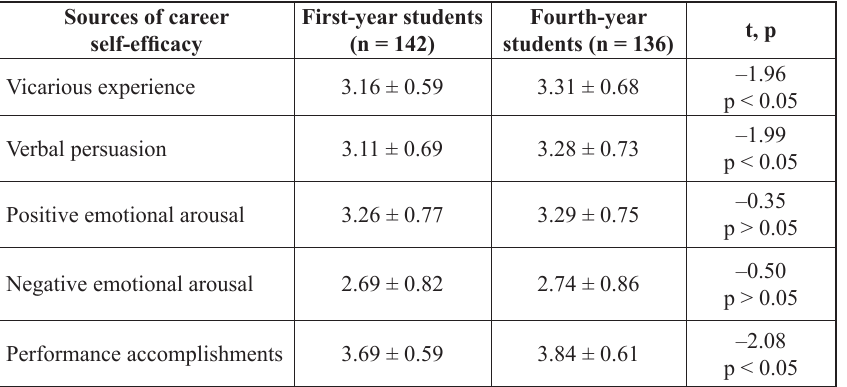
Note. M = mean; SD = standard